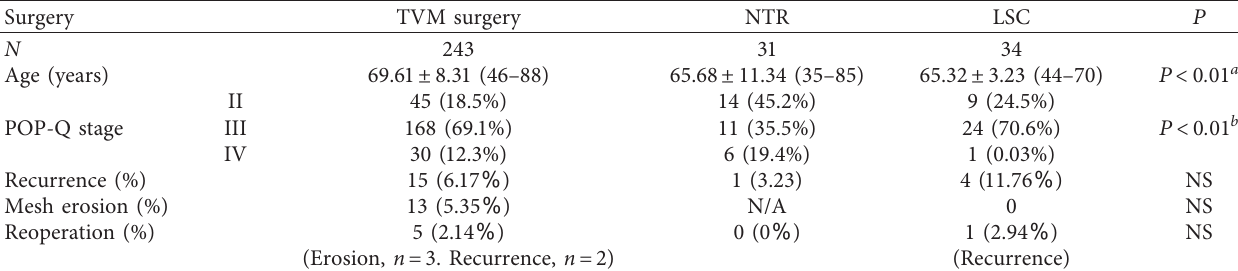
Table 1: Surgical procedures and postoperative